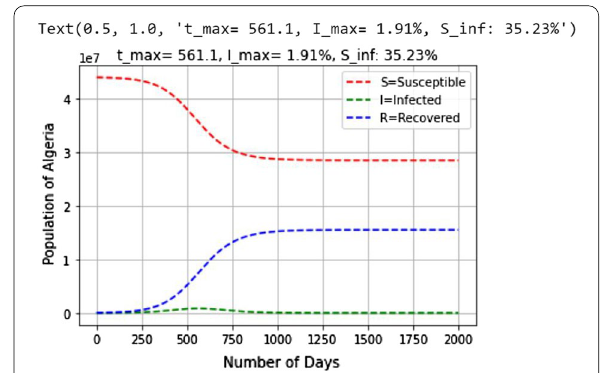
Fig. 6 Estimated values of t max , I max and S inf in